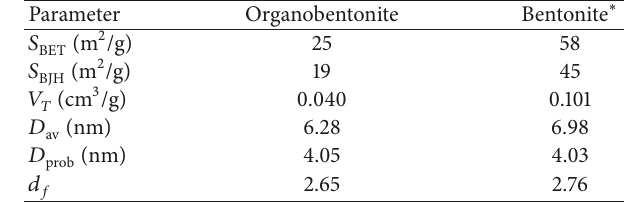
Table 1: Quantitative adjectives of the particle-size distributions for the researched powders.